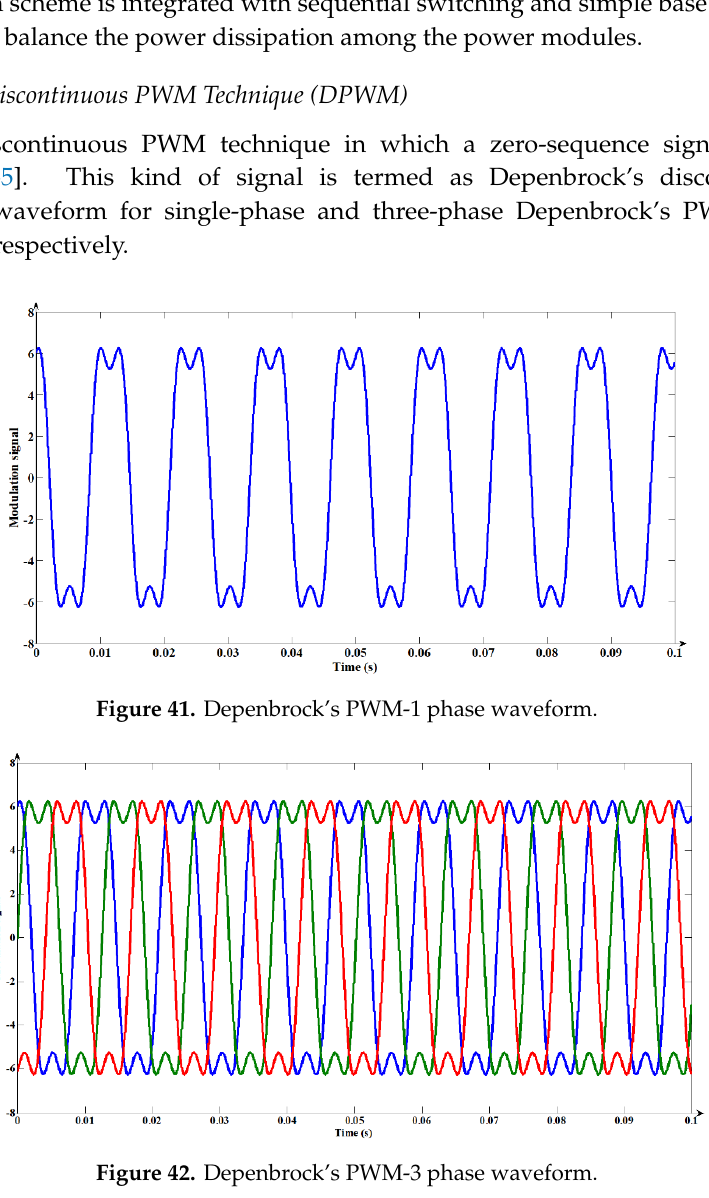
Figure 40. Waveform for hybrid PWM technique.